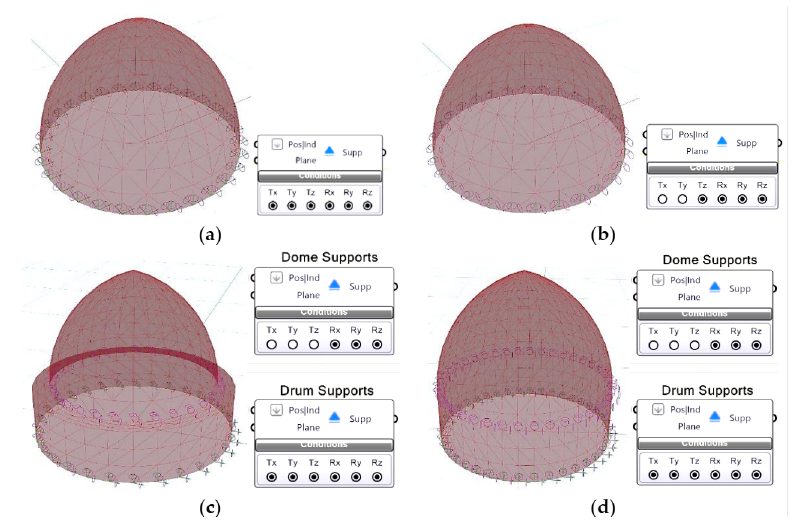
Figure 4. ( a ) Fixed, and ( b ) free in X and Y; ( c ) free in all axes (domes placed on a drum with a pendentive); ( d ) free in all axes (domes placed on a